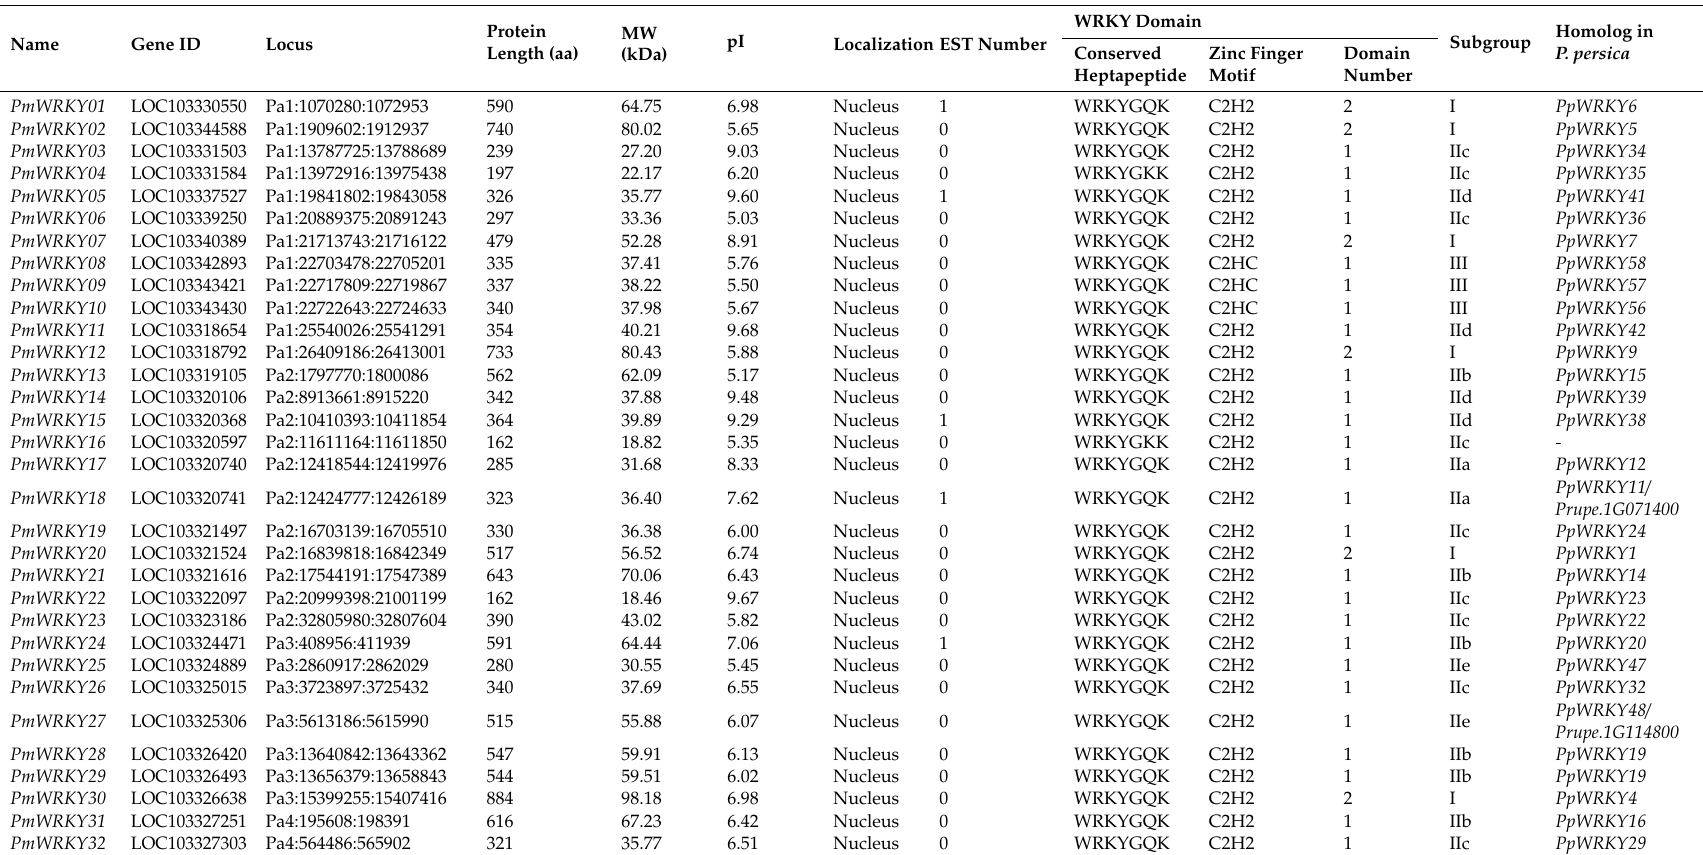
Table 1. Characteristics of the WRKY genes identified in Prunus mume